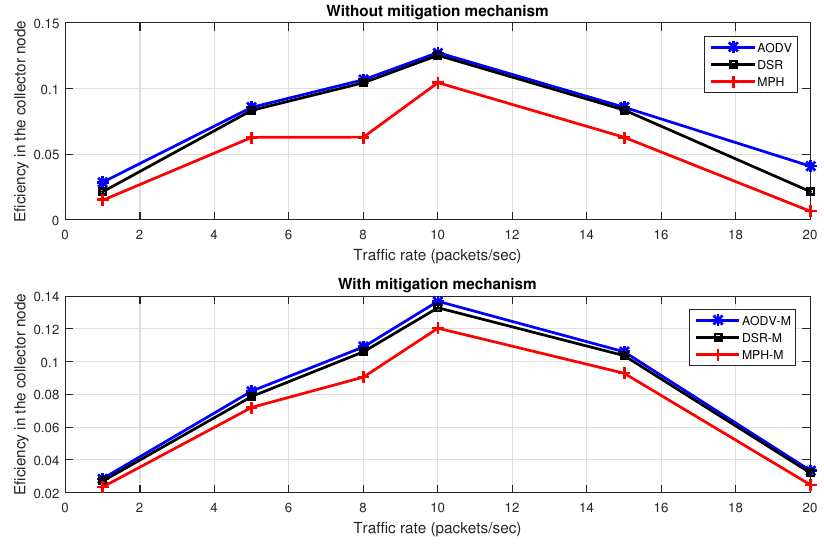
Figure 17. Throughput for different data rate for AODV, DSR, MPH, AODV-M, DSR-M and MPH-M under jamming.